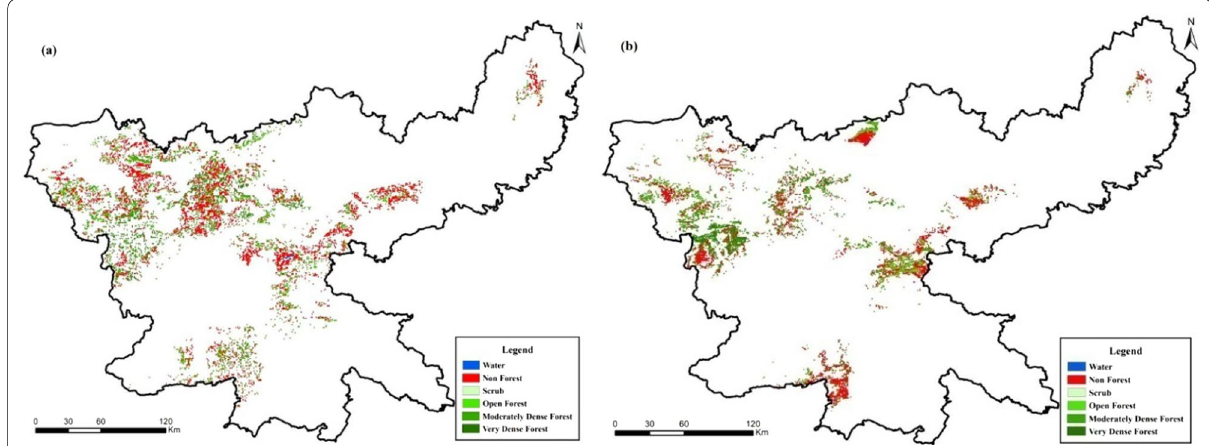
Fig. 8 Map depicting projected habitat distribution area of L. camara for ( a ) high risk zone (AUC: 0.50–0.70), ( b ) critical risk zone (AUC: > 0.70) vulnerable to infestation under different forest cover in Jharkhand for the year